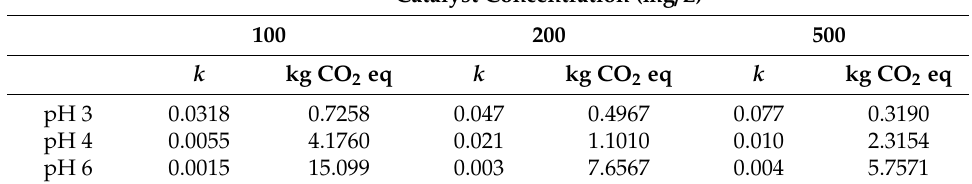
Table 7. Kinetic constant for the degradation and comparison of the CCP (kg CO 2 eq) results of degradation processes at di ff erent Fe 3 O 4 / HA concentrations in the presence of H 2 O 2 (1 mM) at di ff erent pH levels.